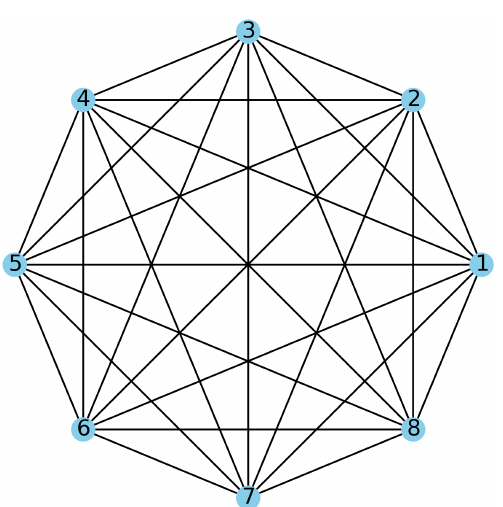
Figure 3. Example Networks as Specific Connected Components. Example networks are composed of fully connected components with 8 nodes and 28